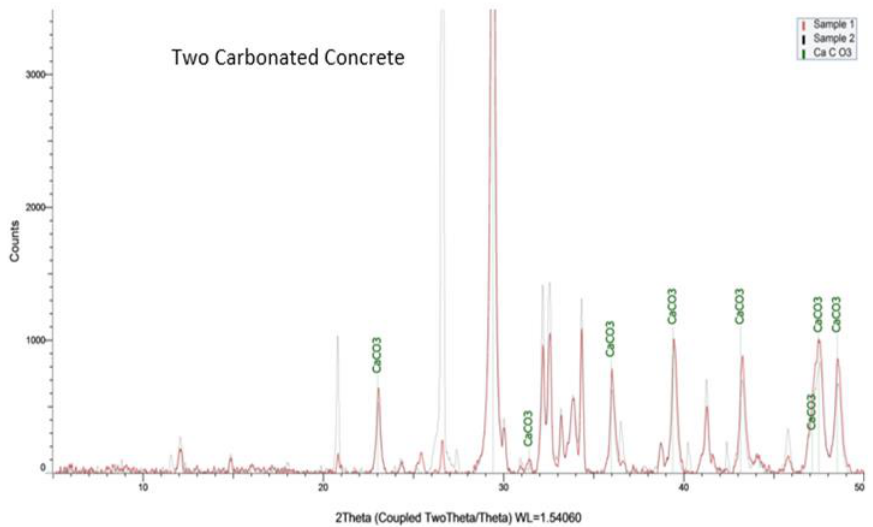
Figure 14. XRD analysis showing CaCO 3 peaks in carbonated mortar samples. Sample 1 (red line) is 6.55% carbonated, while sample 2 (black line) is 1.94% carbonated [28].